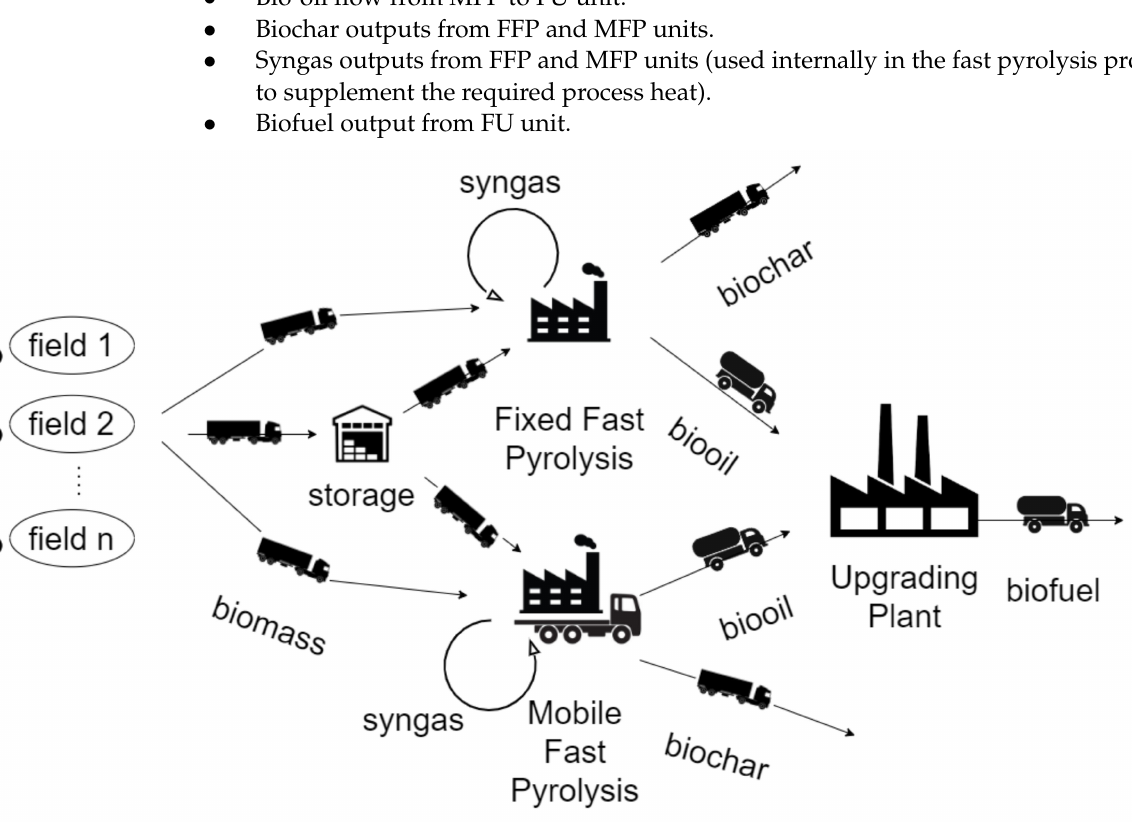
Figure 1. Biomass-to-biofuel supply chain